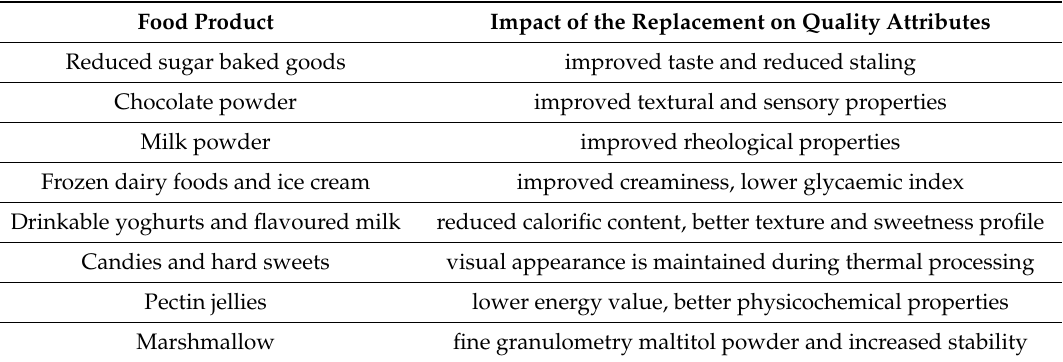
Table 3. A summary of common food products where sucrose is replaced with